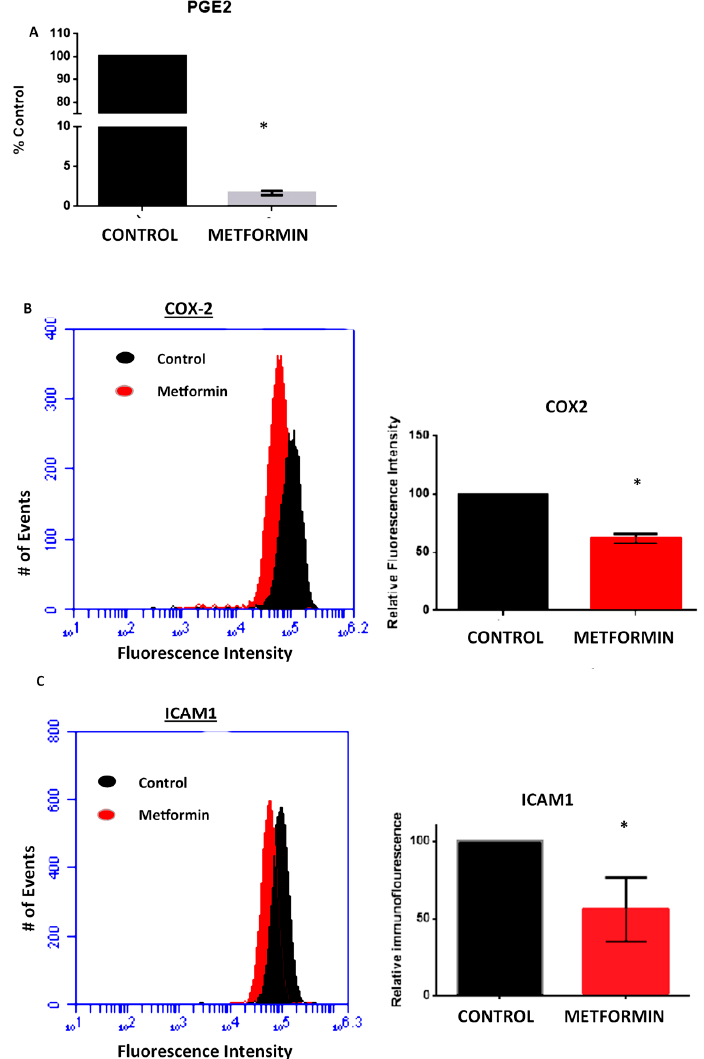
Figure 3. Metformin represses expression of pro-inflammatory markers in breast cancer. ( A ) MDA-MB-231 cells were incubated with or without metformin for 3 days and levels of PGE2 in the culture supernatant measured by competitive ELISA. MDA-MB-231 breast cancer cells were cultured in the presence or absence of metformin for 48 h after which cells were fixed and immunofluorescently stained for ( B ) COX2 or ( C ) ICAM1 protein expression. Staining intensity was measured by flow cytometry and normalized to control for comparison (right of histogram). Flow cytometry assays were performed in quadruplicate with 10,000 events registered per replicate. ELISA was performed with 4 technical repeats on 2 experiments. Significance was determined using Student’s t -test, where * p ≤ 0.05.